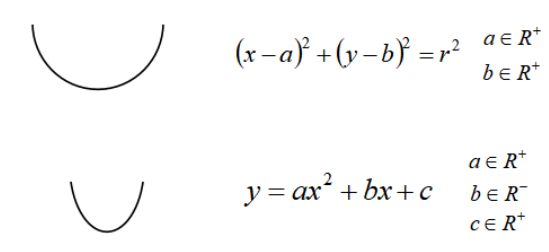
Figure 11. Alternative model for